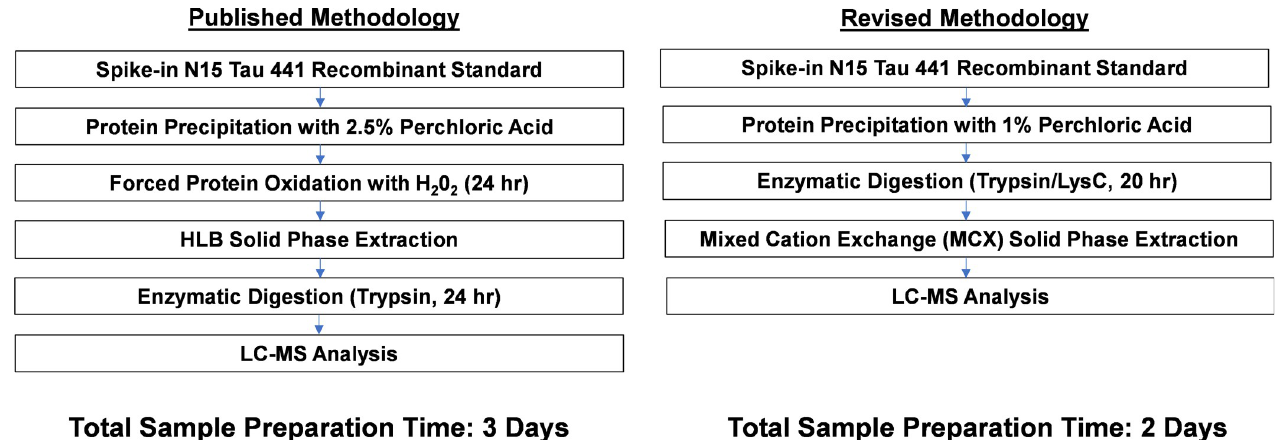
Fig 1. Sample preparation workflow for downstream CSF Total Tau LC-MS analysis. A. Protocol published in the literature that served as a foundation for the final analysis. B. Adaptations from the published protocol that were used as the final assay protocol for validation.